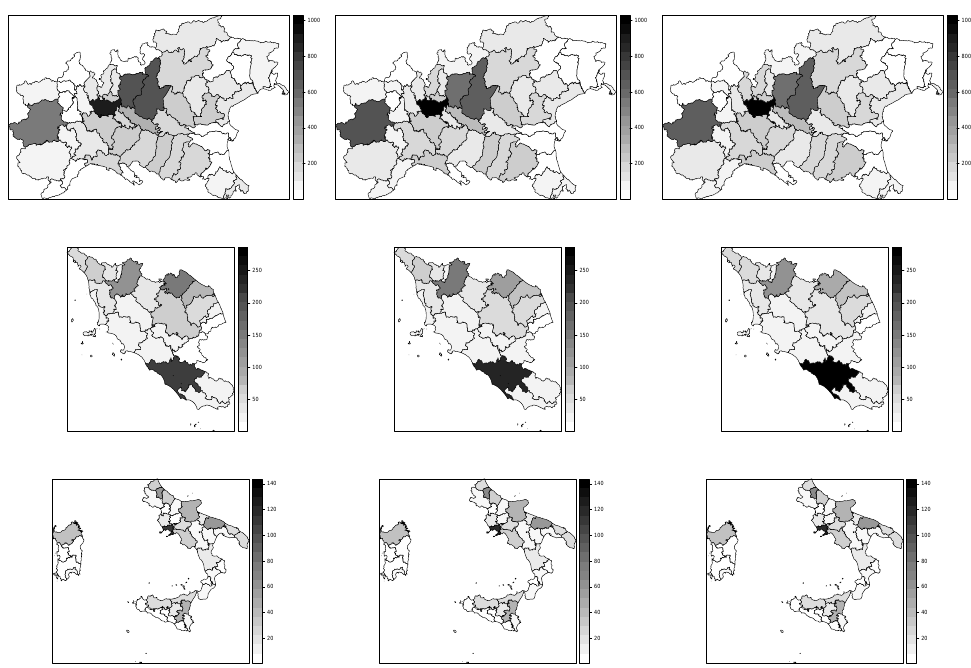
Figure 4. Province-specific relative risks of COVID-19 cases ζ i = exp ( v i + u i ) in Italy under the chosen model (temporally structured interaction) by macro-region for the three phases considered. The color scales are also fixed by macro-region to compare the overall spatial risk of infection better. The overall risk is way higher in the Northern regions and provinces, decreasing from the North to the South of Italy for the given temporal frames.